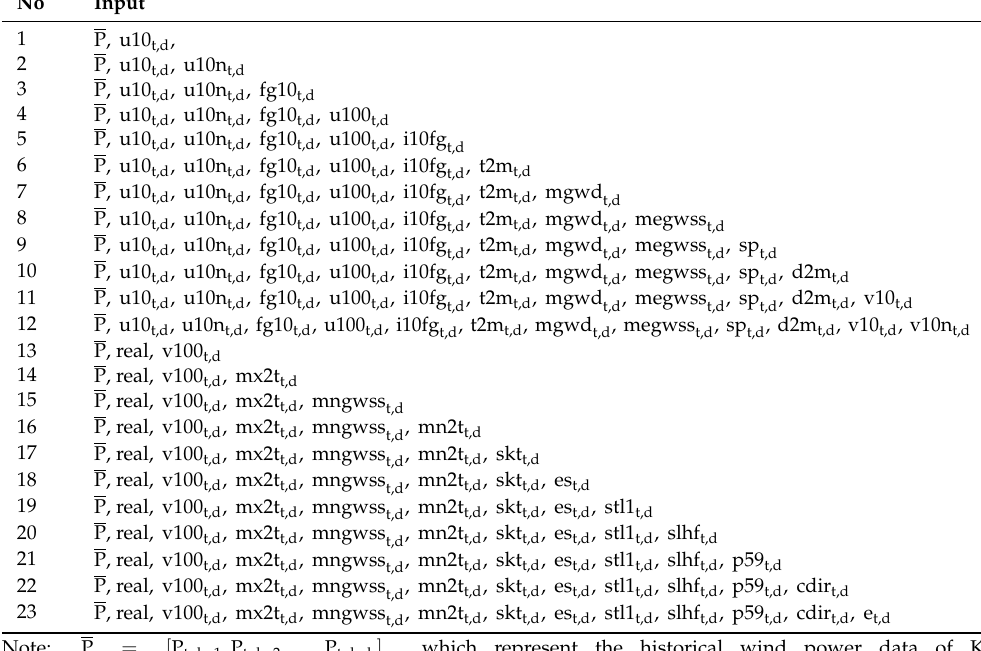
Table 3. The candidate inputs from reanalysis data via the